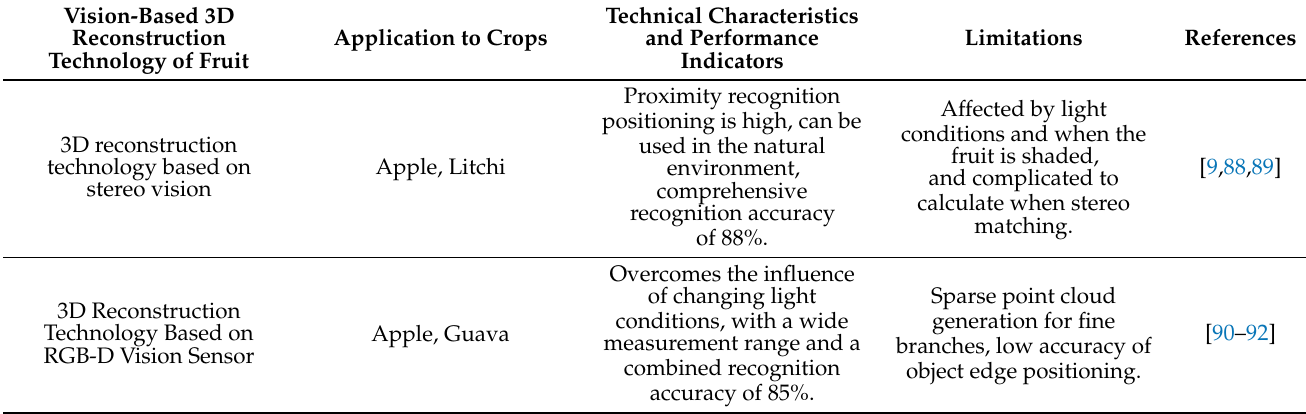
Table 4. Comparing the research results of vision-based 3D reconstruction technology of fruit. Vision-Based 3D Technical Characteristics Reconstruction Application to Crops and Performance Technology of Fruit Indicators